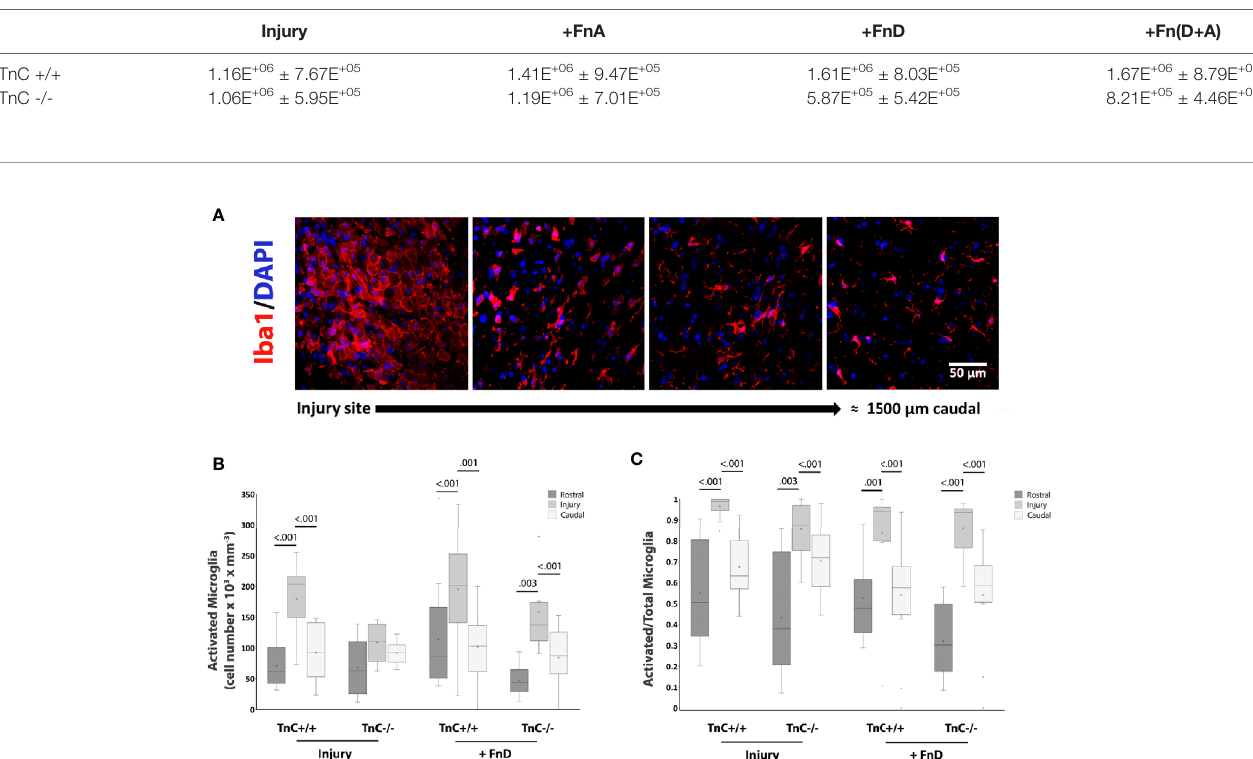
TABLE 6 | Mean values ± standard deviations of GFAP immunoreactivity at the injury site of the spinal cord.